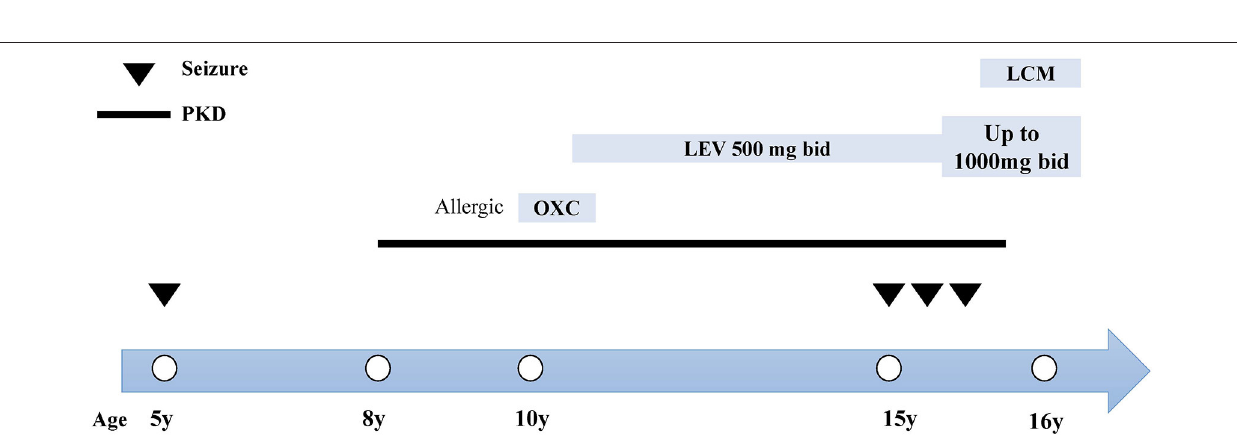
FIGURE 2 | Clinical course and treatment of the case. The x-axis indicates the age of patient at each attack. Epileptic seizures are indicated by inverted triangles. The course of PKD is denoted by the black line. The name, dosage and timing of drug treatment are shown at the top of the diagram. bid, twice daily; LCM, lacosamide; LEV, levetiracetam; OXC,